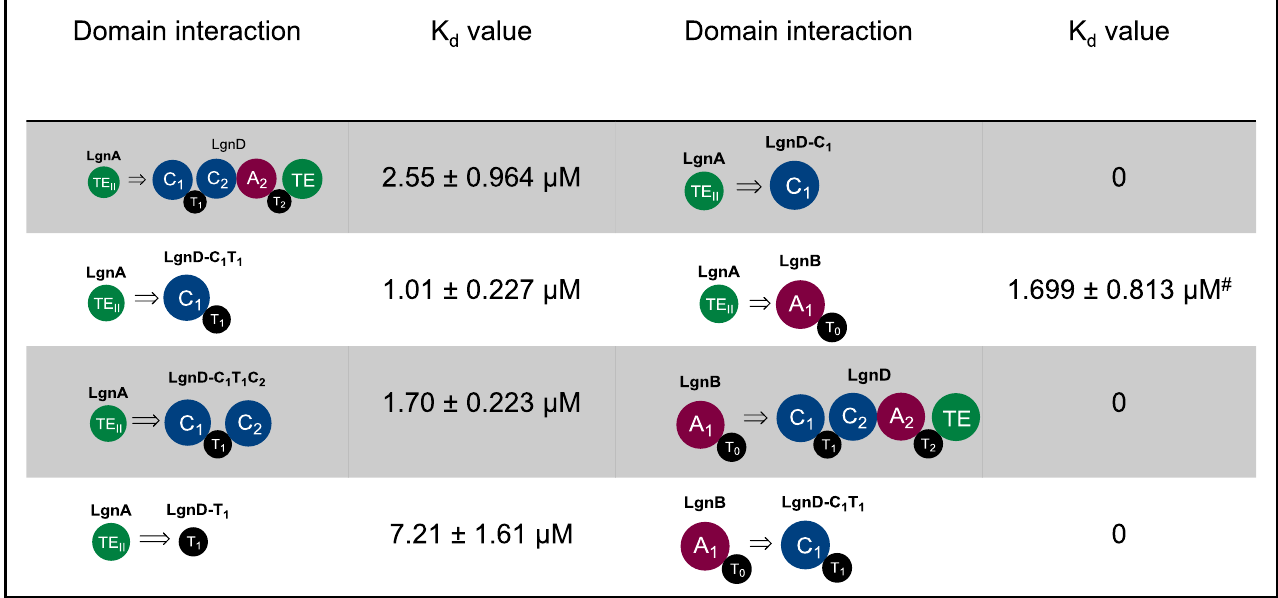
Table 1 Summary of ITC and MST assays of domain interactions of LgnA with LgnD, truncated LgnD proteins and LgnB as well as LgnB with LgnD and truncated LgnD